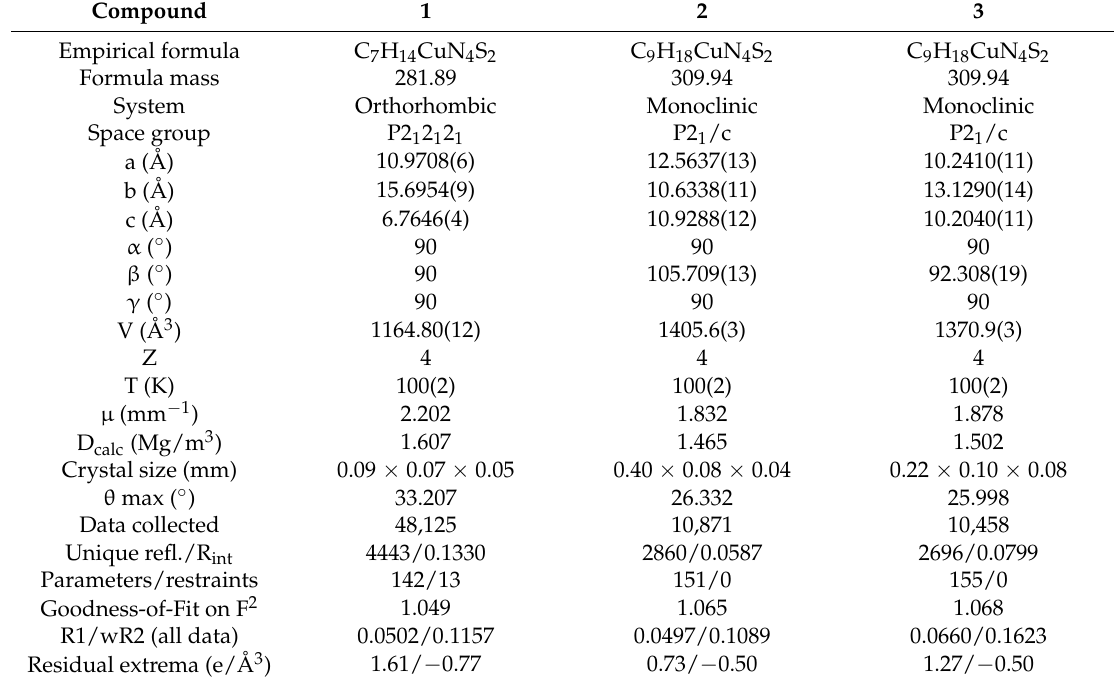
Table 4. Crystallographic data and processing parameters for 1 – 3